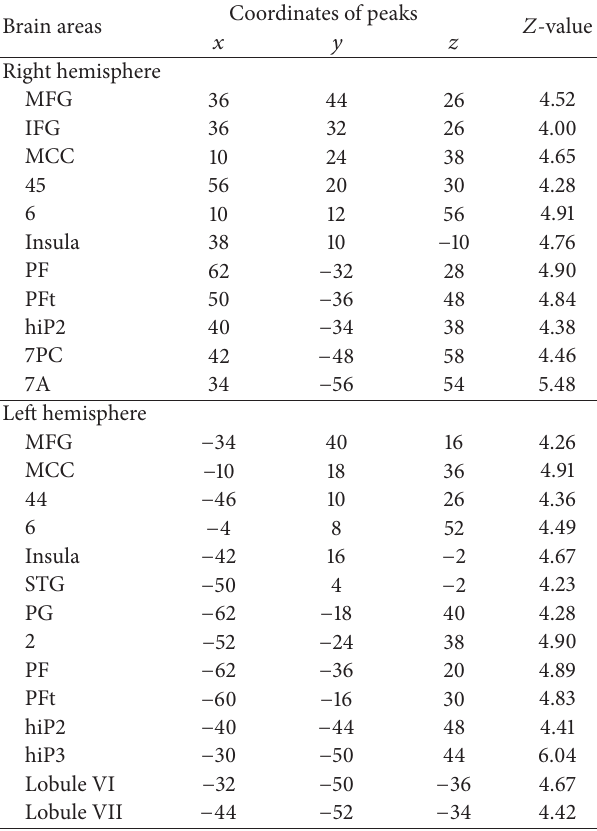
Table 1: Brain regions where activity was negatively correlated with the number of correct sequences (PERFROMANCE image).